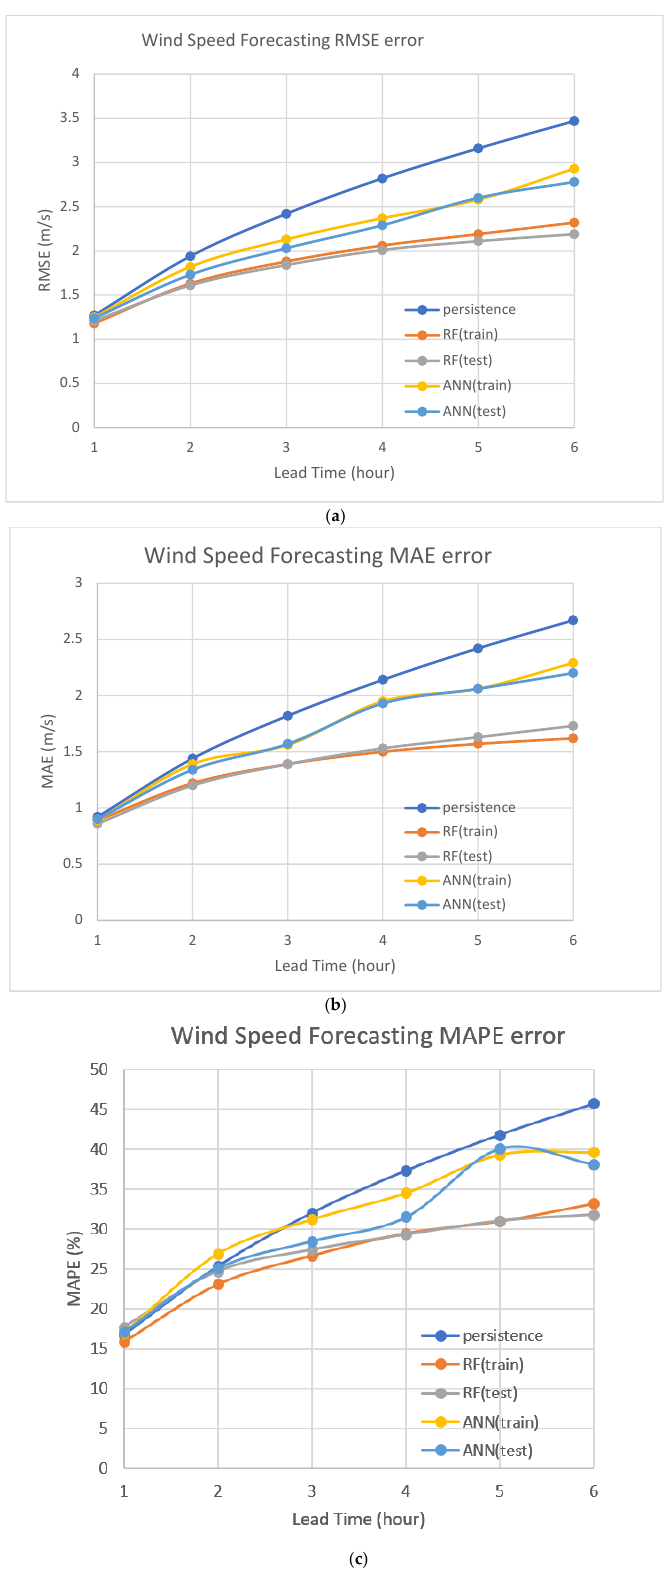
Figure 9. The comparisons among the performances of the persistence model, RF model, and ANN model. ( a ) Comparison of RMSE, ( b ) comparison of MAE, ( c ) comparison of MAPE. Table 5. The error criteria of the persistence model, the RF model, and the ANN model.